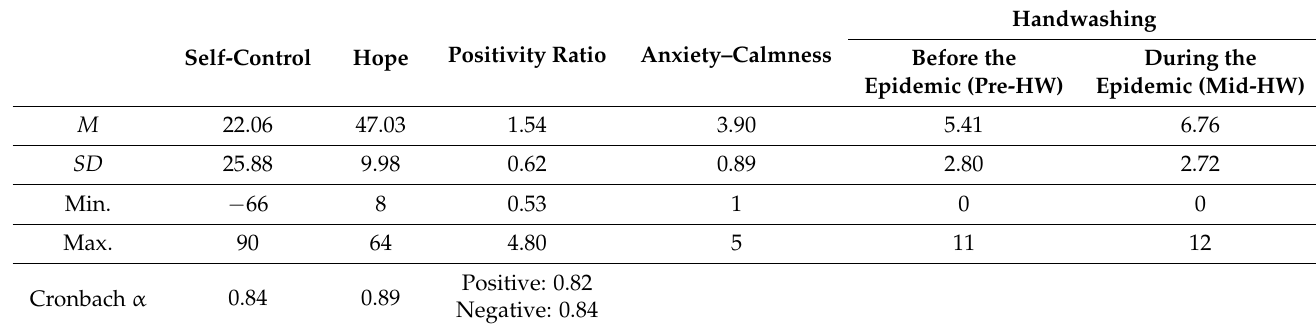
Table 1. Means, standard deviations, and maximum and minimum values of study variables ( n = 537).